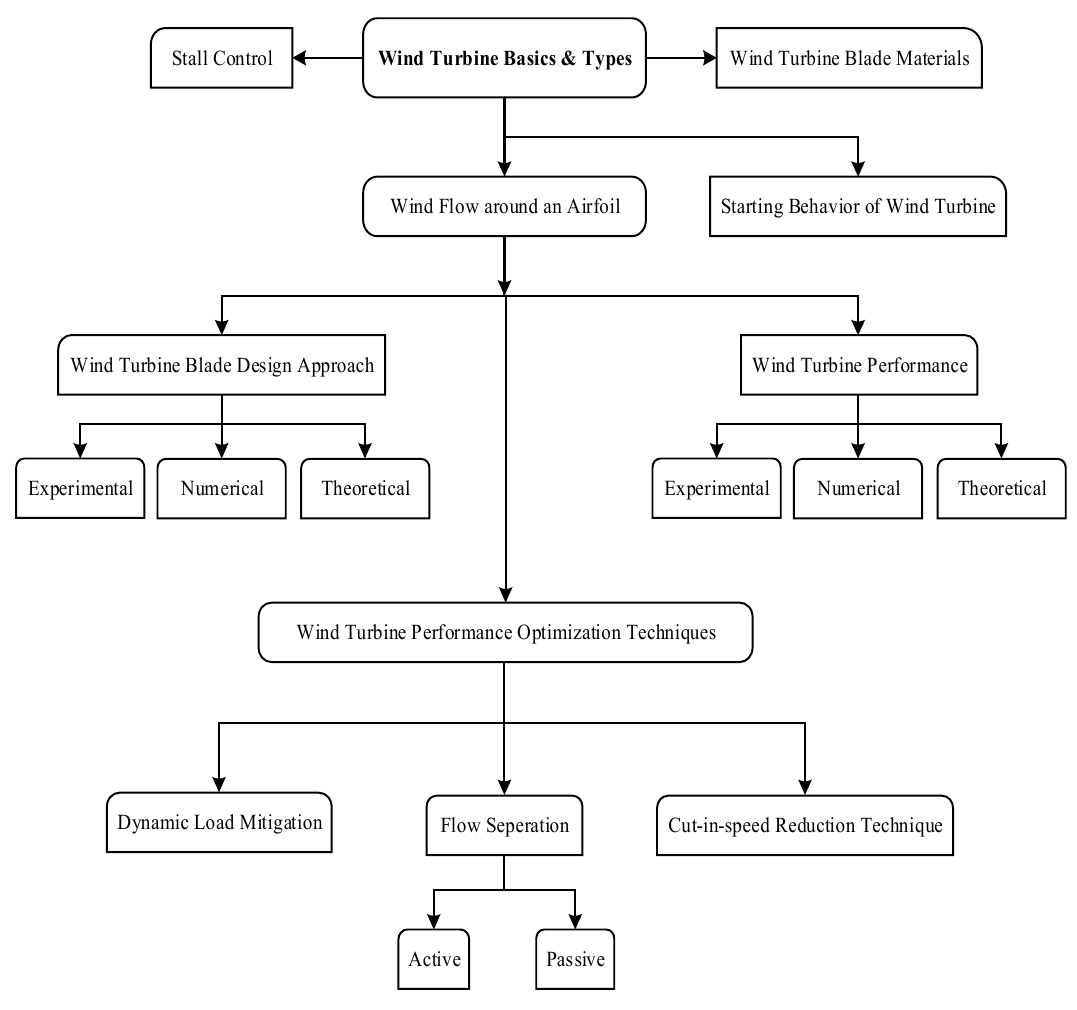
Figure 3. Topics and sub ‐ topics reviewed in this study.